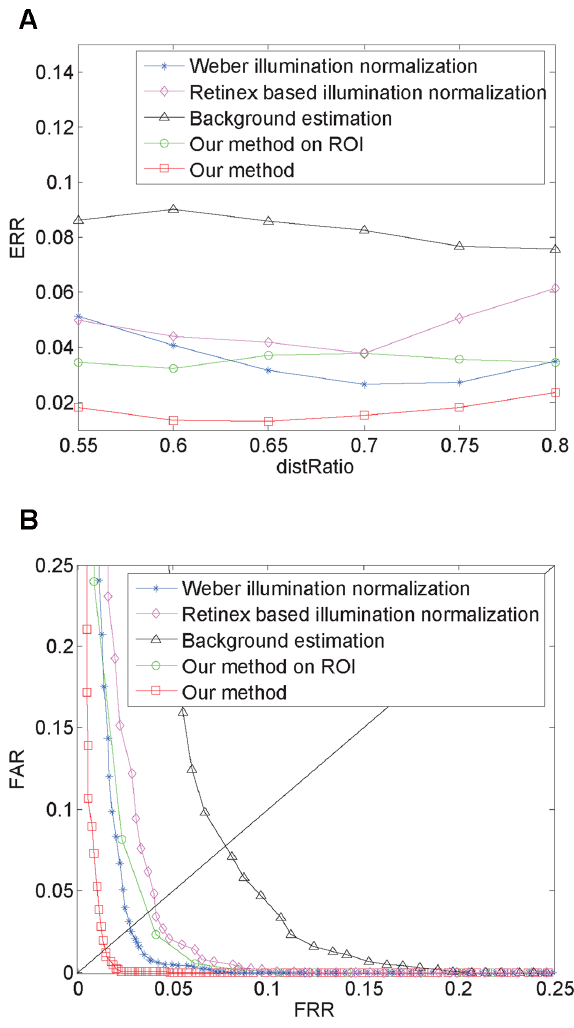
Figure 13. Comparative experiment using five different preprocessing methods. (a) EERs of the five preprocessing approaches for different distRatio values; (b) EER curves for the five preprocessing approaches for an optimal distRatio. doi:10.1371/journal.pone.0097548.g013 Figure 12 illustrates the final results obtained from the five